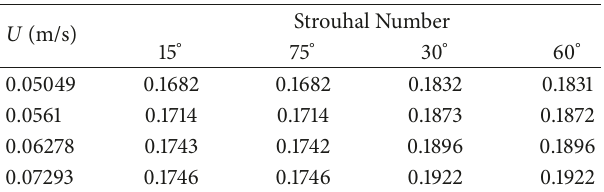
Table 3: Comparison of Strouhal Number with different attack